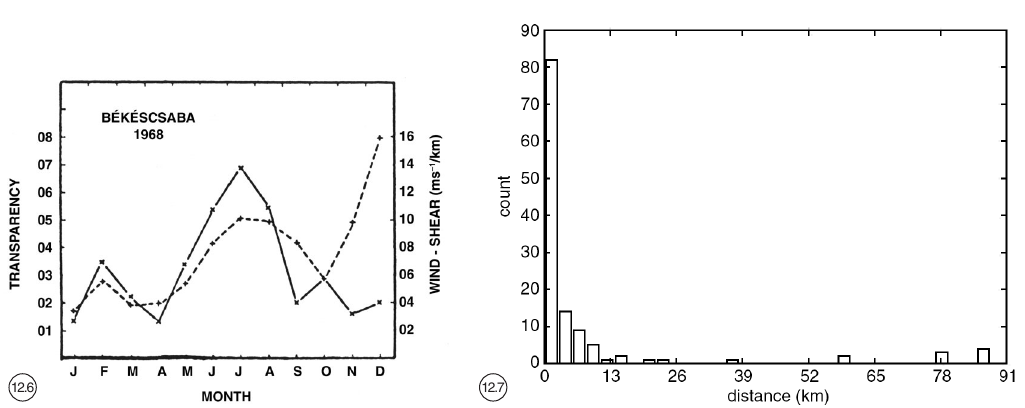
Fig. 12.6. Seasonal variations of transparency of Es -layers and wind-shear (Bencze and Märcz, 2002). Fig. 12.7. Preliminary spectrum of the distances between patches in sporadic E -layers (indicating the distance between screenpoints in case of a thin diffraction screen).